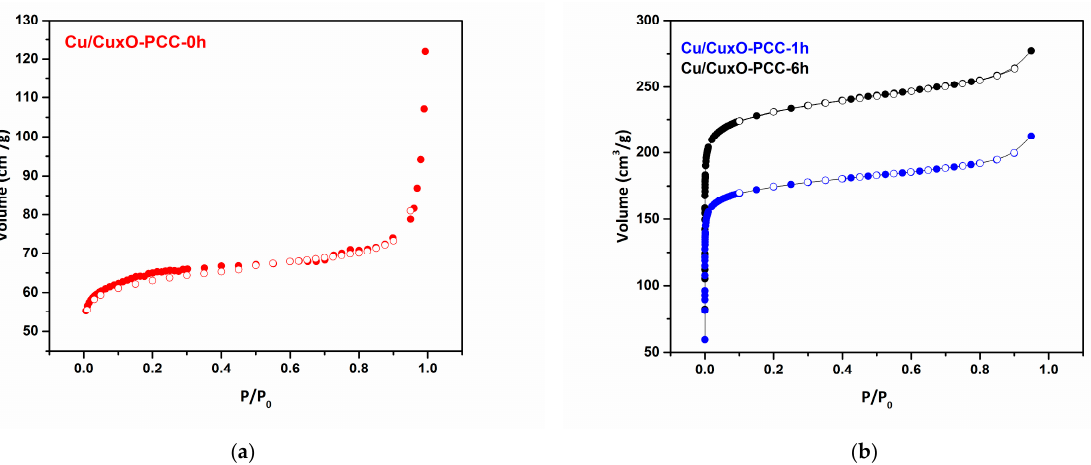
Figure 5. ( a ) adsorption-desorption isotherm of the unleached PCC catalyst, Cu/Cu x O-PCC-0h ( b ) adsorption-desorption isotherms of the leached PCC catalysts, Cu/Cu x O-PCC-1h, Cu/Cu x O-PCC-6h.